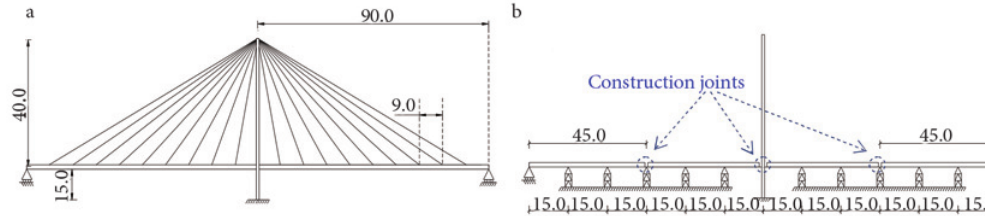
fig. 5. Cable-stayed bridge in WuXi, X 18 : a − geometry, m; b − girder on temporary supports,